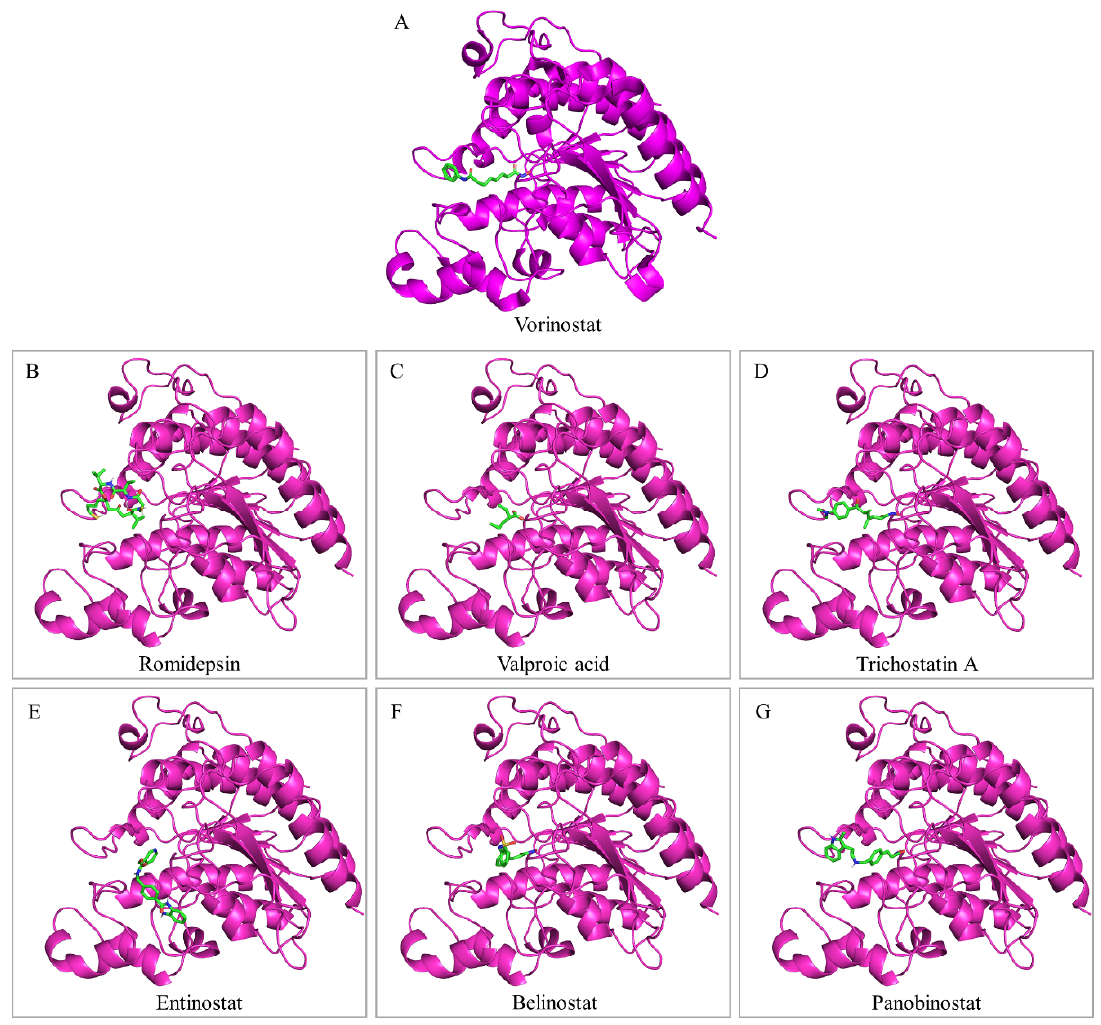
Figure 5. HDACis’ common mechanism of action. Based on ( A ) the experimentally determined structure of human HDAC2 (magenta) in complex with vorinostat (PDB ID: 4LXZ [198]), docking experiments were carried out for the herein reviewed inhibitors, by suitably engaging the AutoDock Vina bioinformatics platform [199]. Docking results of ( B ) romidepsin, ( C ) valproic acid, ( D ) trichostatin A, ( E ) entinostat, ( F ) belinostat and ( G ) panobinostat (green) with HDAC2 indicate that HDACis share a common pattern of structural recognition and molecular mechanism to convey